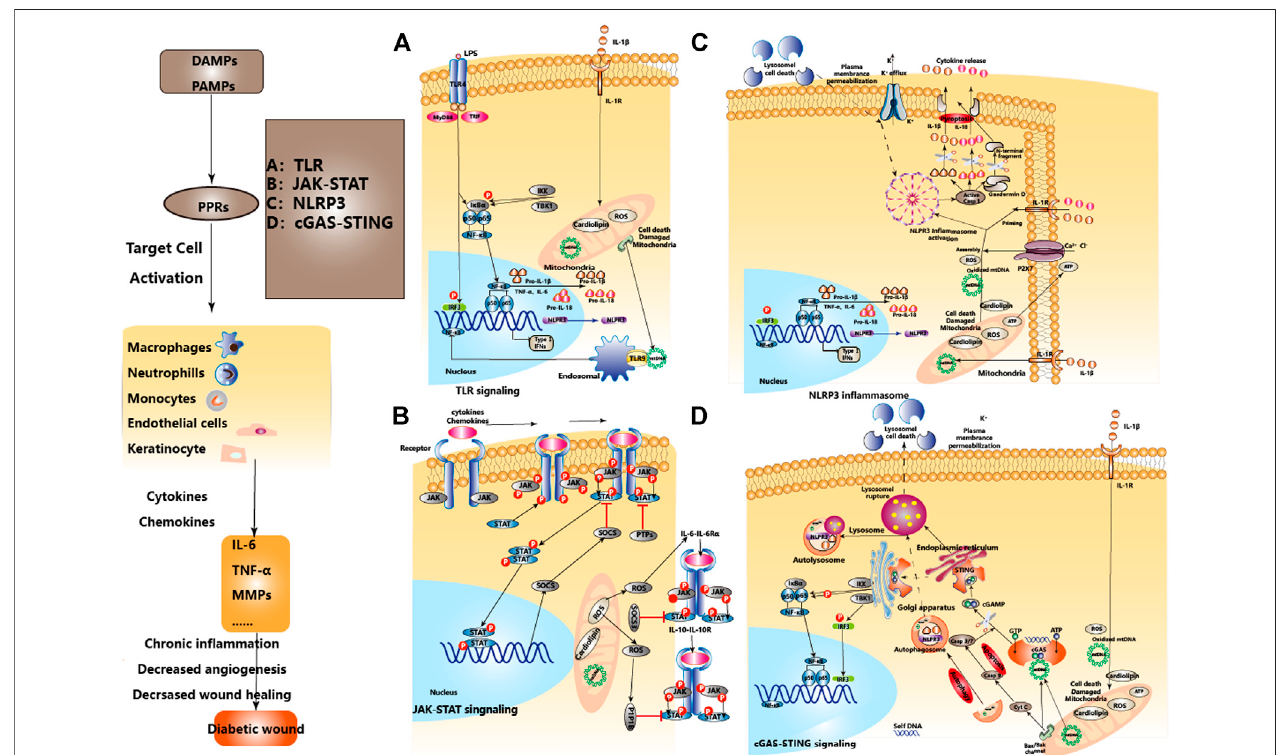
FIGURE3| TheregulatoryrelationshipbetweendifferentinnateimmunepathwaysinDWandhomeostasis.TheeffectsoftheregulatoryrelationshipbetweenTLR, JAK-STAT,NLPR3,cGAS-STINGsignal pathways, and homeostasis in DW.Afterthe formationofDW, PAMPsand DAMPs activate PRRsasinitiating factors, inducing the activation of TLR, NLPR3, and cGAS-STING signal pathways, activate the expression of type I interferon and other immunoregulatory molecules. JAK-STAT mediates extracellular-nuclear regulation of various cytokines/chemokines. Mitochondrial damage, endoplasmic reticulum stress, and lysosomal membrane permeabilization are involved in the activation and regulation of signal pathways. Mitochondrial autophagy and apoptosis play an immune silencing role in maintaining immune homeostasis. A, B, C, and D represent four signaling pathways respectively.